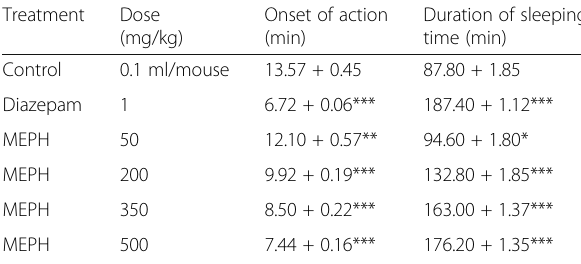
Table 5 The effect of MEPH on thiopental sodium-induced sleeping time test in mice